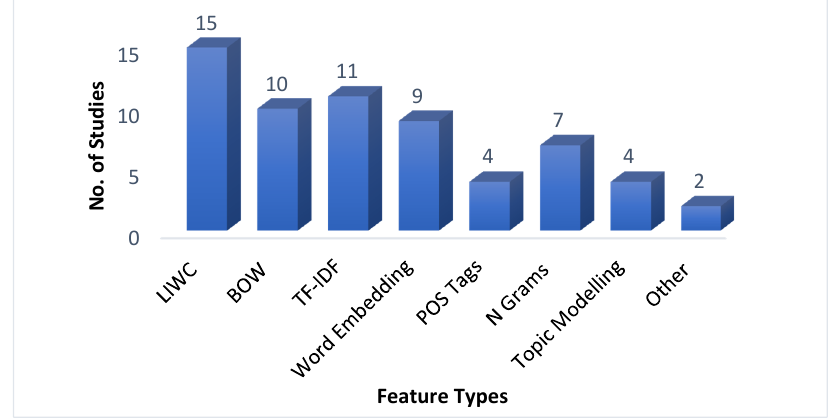
Figure 3. Analysis of textual features used on selected studies.